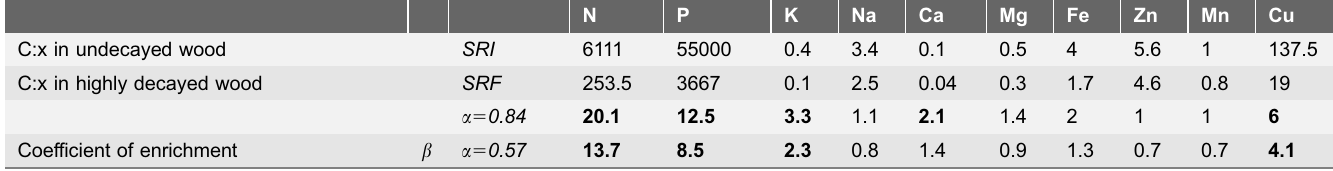
Table 3. Coefficient of enrichment of elements in decaying wood (see text for